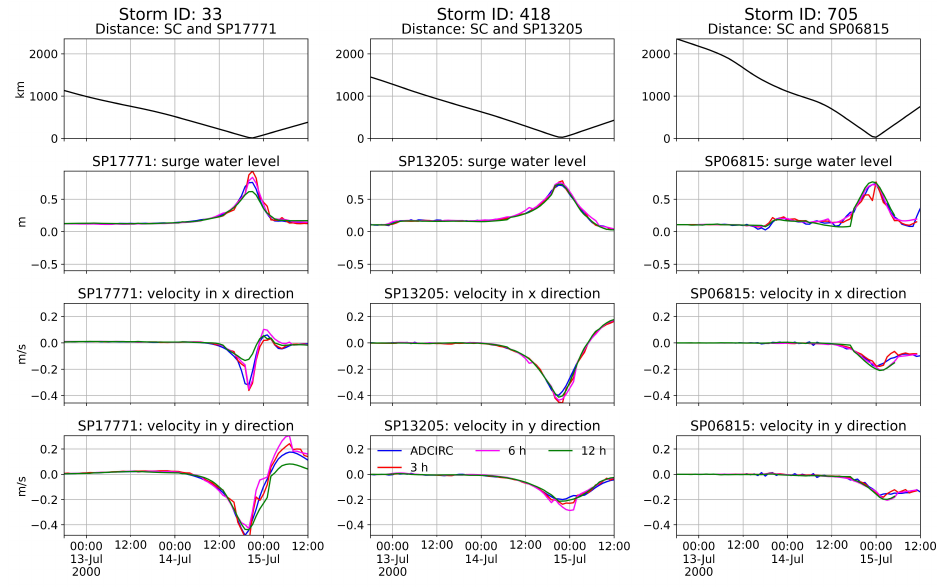
Figure 13. Comparison of storm surge water level and velocity induced by the landfalling storms 33, 418, and 705 at three save points SP17771, SP13205, and SP06815, respectively. Forecast using three lead times (i.e., 3 h, 6 h, and 12 h) were compared with ADCIRC